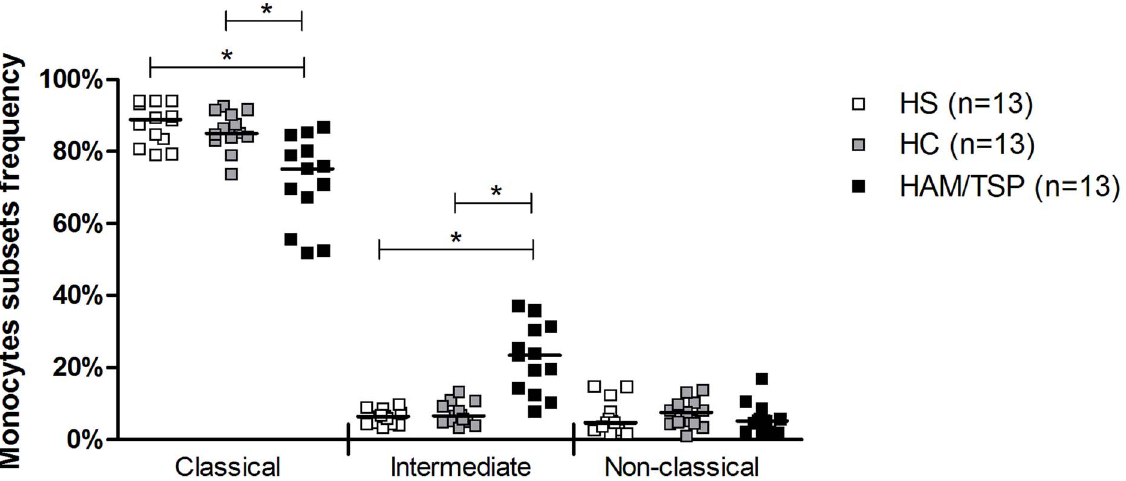
Fig. 1. Frequencies of the monocyte subsets. Monocytes from healthy subjects (HS, n=13), from HTLV-1 carriers (HC, n=13), and from HAM/TSP patients (n=13) were selected from the size and cell granularity and then subdivided into classical (CD14 ++ CD16 - ), intermediate (CD14 + CD16 + ) and non-classical monocytes (CD14 + CD16 ++ ). Data of the monocyte subsets frequency is represented by median. Kruskal-Wallis followed by Dunn’s post test were used for statistical analyses (* P ,